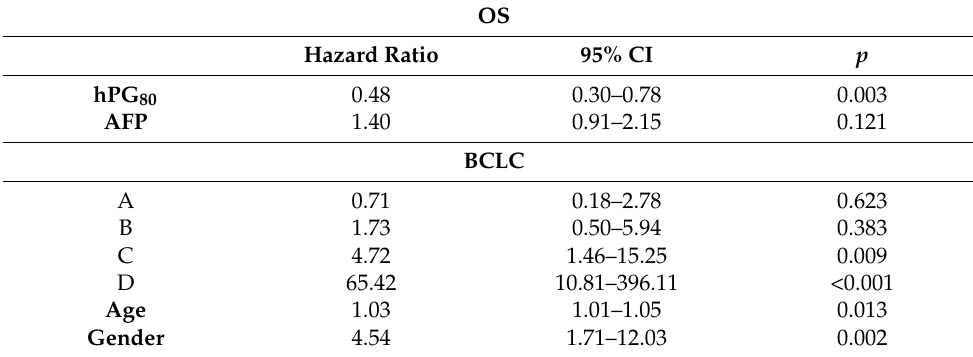
Table 4. hPG 80 multivariate Cox